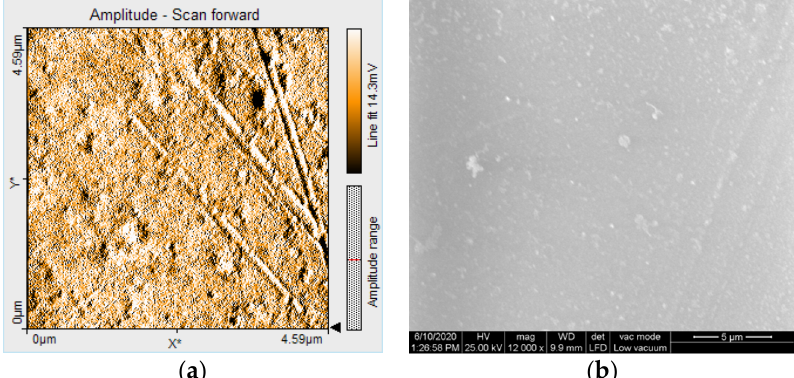
Figure 18. ( a ) Scanning amplitude (AFM) and ( b ) corresponding SEM image for a sample (DCT) with low nanoroughness values: Sa = 1.6 nm, Sp = 5.8 nm, Sv = − 12 nm.